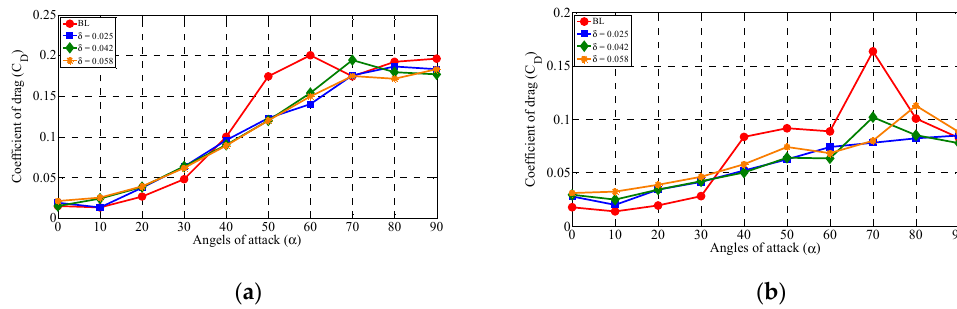
Figure 13. The aerodynamic behavior of drag coefficient for different circular slot ratios and vari- ous angles of attack at ( a ) θ = 30° and ( b ) θ = 60°.